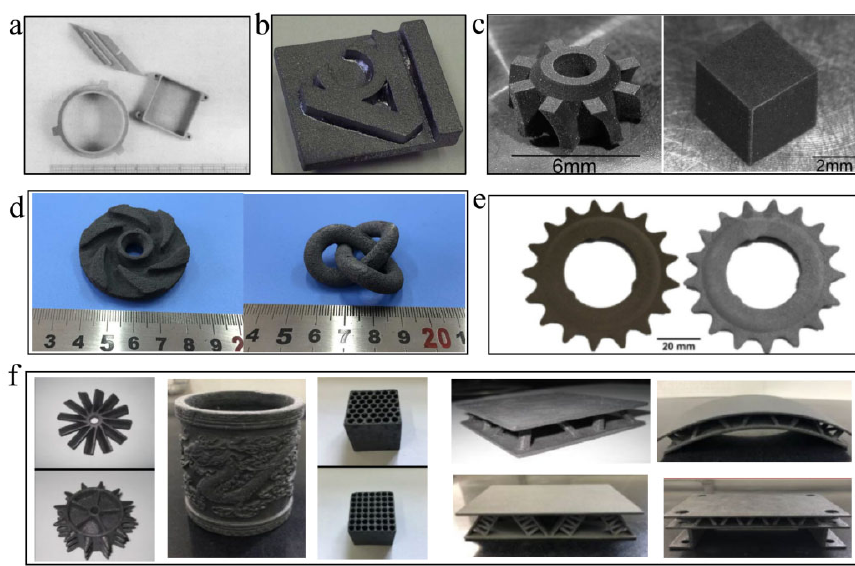
Fig. 10 SLS of SiC ceramic: (a) PMMA coated SiC powder, SLS. Reproduced with permission from Ref. [44], © American Chemical Society 1995. (b) SiC powder, SLS+high-temperature LSI. Reproduced with permission from Ref. [45], © Emerald Group Publishing Limited 2005. (c) SiC powder+Si powder, LMS. Reproduced with permission from Ref. [46], © Taylor & Francis 2008. (d) PF coated SiC powder, SLS+CIP+RS. Reproduced with permission from Ref. [47], © Elsevier Ltd and Techna Group S.r.l. 2018. (e) SiC powder+Si powder, SLS+resin infiltration+LSI. Reproduced with permission from Ref. [49], © Elsevier Ltd. 2018. (f) SiC powder, SLS+PIP. Reproduced with permission from Ref. [50], © The American Ceramic Society